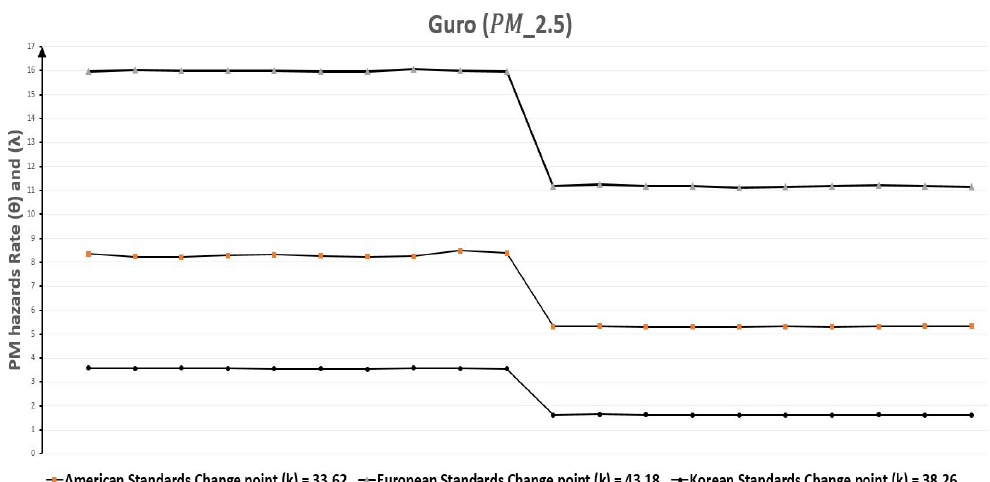
Figure 18. Guro (Seoul, South Korea) monthly polluted days before and after the change point due to PM 2.5